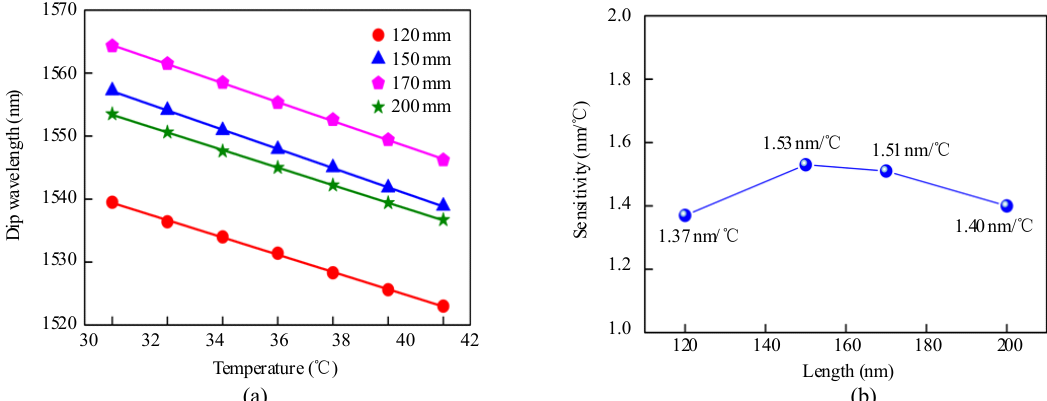
Fig. 4 PMF-based Sagnac interferometer has (a) the dependence on temperature of different PMF lengths and (b) the different distribution of temperature sensitivity.